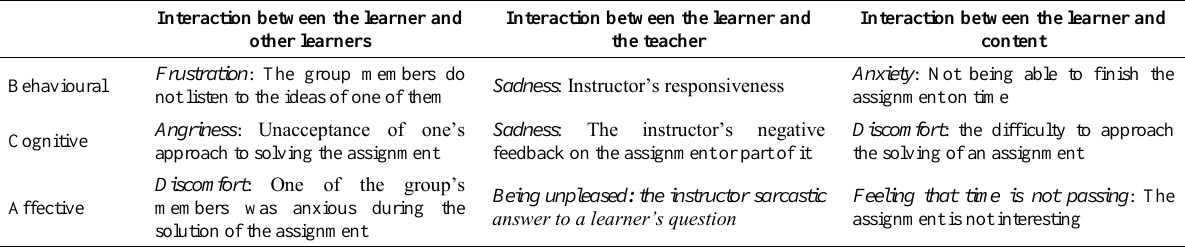
Table 7. Occurrences in the assignments that resulted in a negative affective engagement.